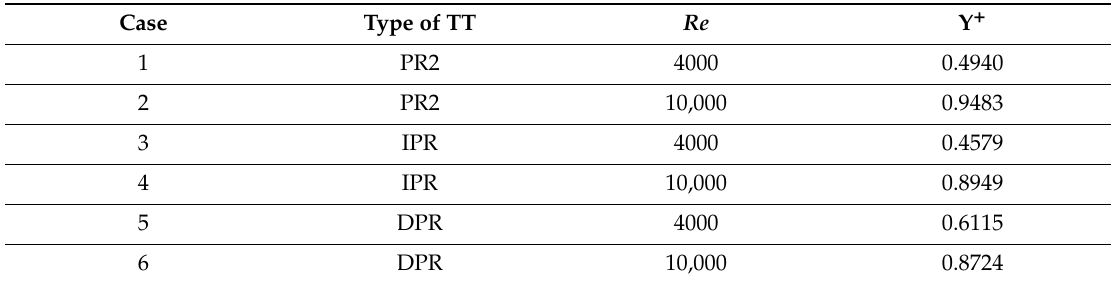
Figure 12. Validation of water flowing inside a smooth circular tube. Table 4. Y + values for various simulation